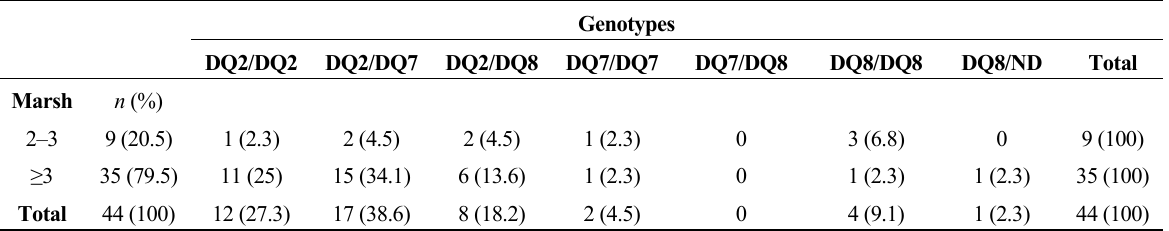
Table 4. Small intestinal biopsy lesions and genotypes in 44 cases of celiac disease.